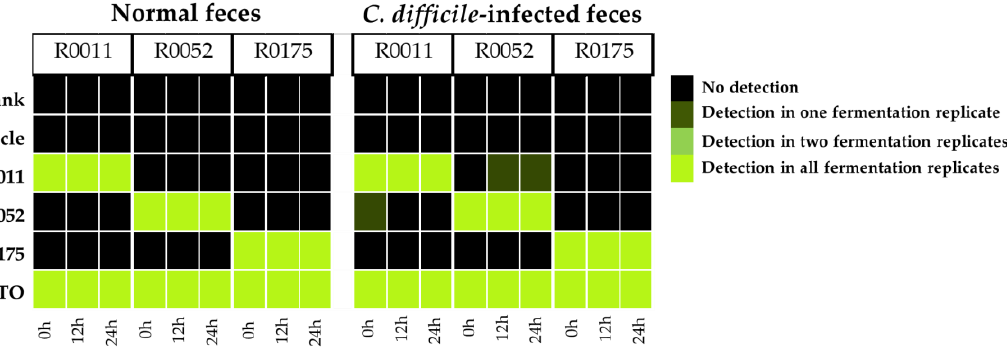
Figure 5. Detection of individual probiotic strains in extracted fecal DNA samples by real-time PCR (qPCR). ( a ) Detection of strain B. longum R0175; ( b ) Detection of strain L. helveticus R0052; ( c ) Detection of strain L. rhamnosus R0011. Each column of the corresponding time point represents an individual experiment along with corresponding quantification cycle (Cq) value. R0011 = L. rhamnosus R0011; R0052 = L. helveticus R0052; R0175 = B. longum R0175; PROTO = ProtecFlor TM .